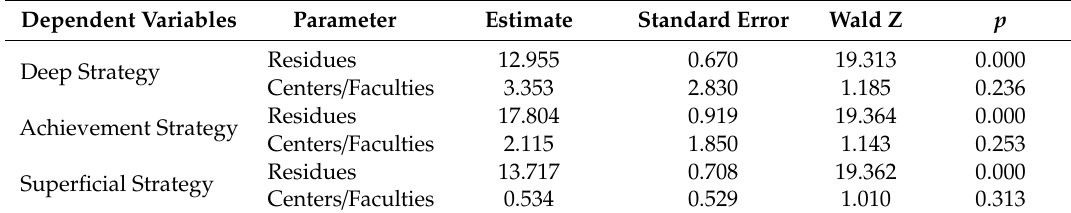
Table 2. Estimates of the covariance